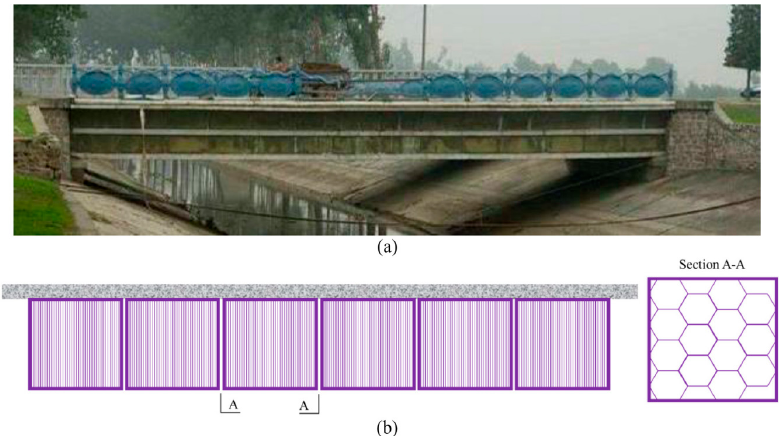
Figure 3. View (a) and cross section (b) of Miyun bridge [39].